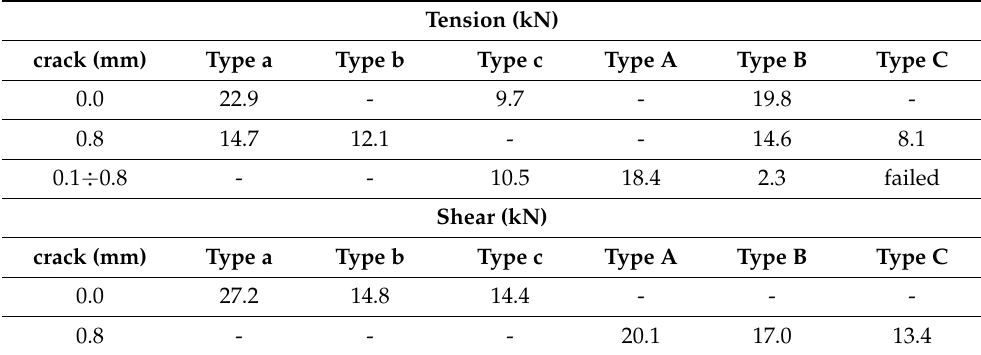
Table 6. Test results in terms of the mean capacity for each combination of crack width and anchor type.